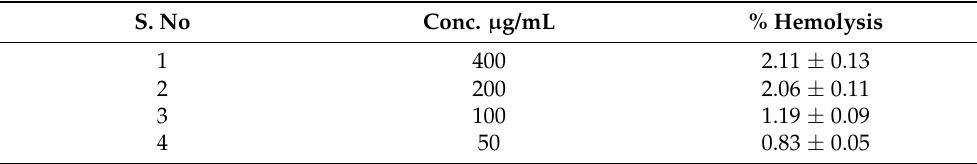
Table 3. % Hemolysis of green synthesized